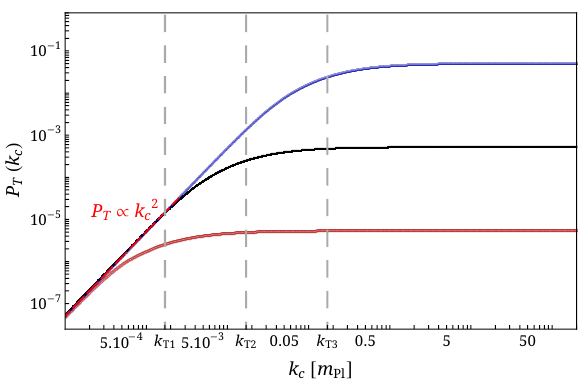
Figure 2. Primordial tensor power spectra from the emergent evolution for different values of H 0 . Lower curve (red): H 0 = 0.001; middle curve (black): H 0 = 0.01; and upper curve (blue): H 0 =